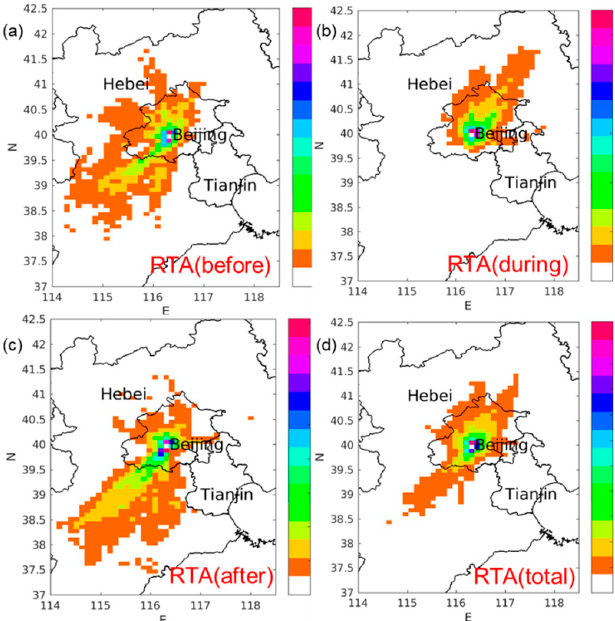
Figure 7. RTAs of the 3 time periods and the whole sampling period. Subplots ( a – c ) are the RTA fields for the “before”, “during”, and “after” periods. Subplot ( d ) is the whole sampling period. The red dot is our sampling site and the particle release point in FLEXPART model. The color bar represents the relative contribution percentage in each grid to the sampling site. From bottom to top side of the color bar, the cell contribution gets